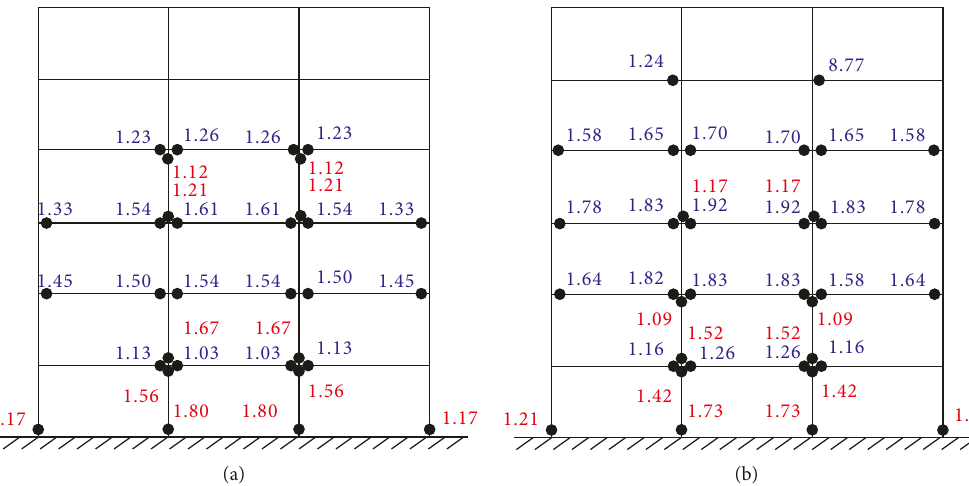
Figure 18: Plastic hinge distribution with 7-degree (0.10 g) fortification intensity. (a) Considering the beam-to-column linear stiffness ratio limit values. (b) Not considering the beam-to-column linear stiffness ratio limit values.